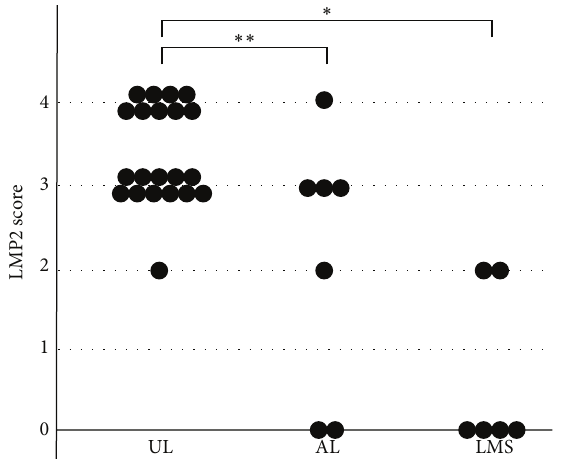
Figure 2: LMP score in SMTs. A significant difference was found in the LMP2 score for UL and AL and for UL and LMS ( ∗ 𝑃 < 0.01 , ∗∗ 𝑃 < 0.05 ).